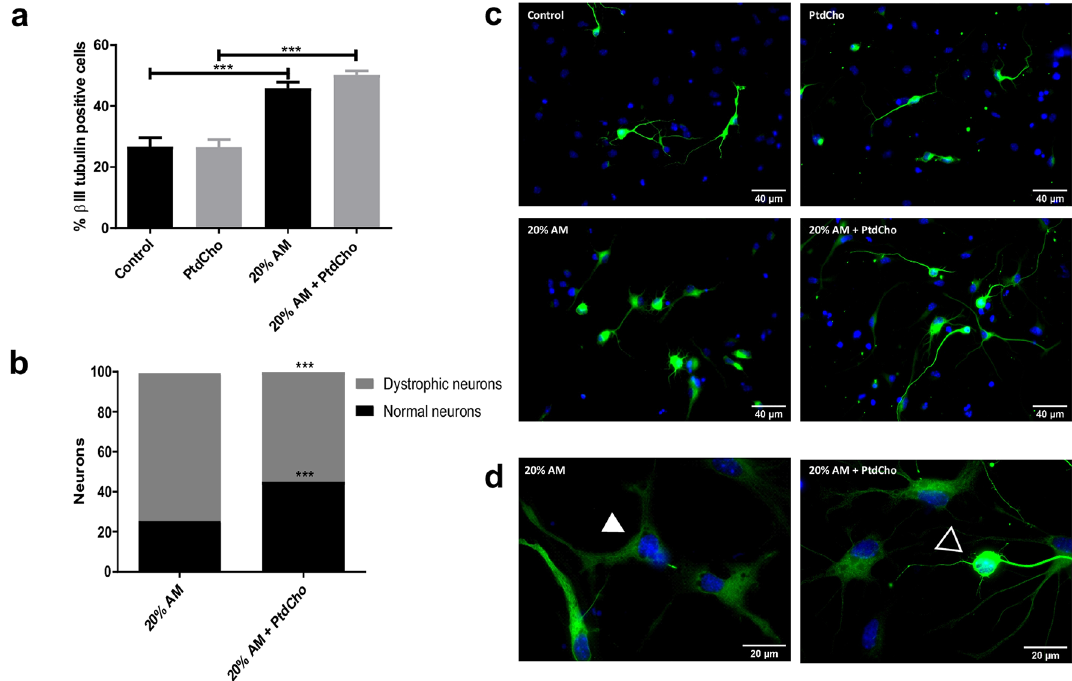
Figure 7. PtdCho restores morphology of dystrophic neurons. ( a ) Percentage of βIII-tubulin positive cells analysed by immunocytochemistry coupled to fluorescence microscopy of NSCs exposed to 20% V/V of AM when PtdCho was added later on, after 1 day of culture, and incubated for 3 days. Graph represents the percentage of neuronal differentiation measured in three independent experiments. Data were presented as mean ± SEM. ***p < 0.001. ( b ) Percentage of normal neurons (black bars) and dystrophic neurons (grey bars) after 3 days in culture under the indicated conditions. ***p < 0.001 (Student’s T-test). ( c ) Representative images (× 40) of neurons incubated under the indicated conditions Scale bars: 40 μm. ( d ) Representative images of neurons morphology under the indicated condition (× 100). Open arrow indicates normal neuron and white arrow indicates dystrophic neuron. Scale bars: 20